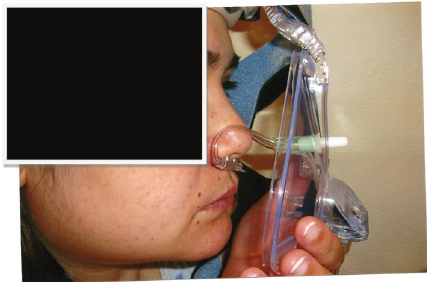
Figure 1: Application of dual mask to patient